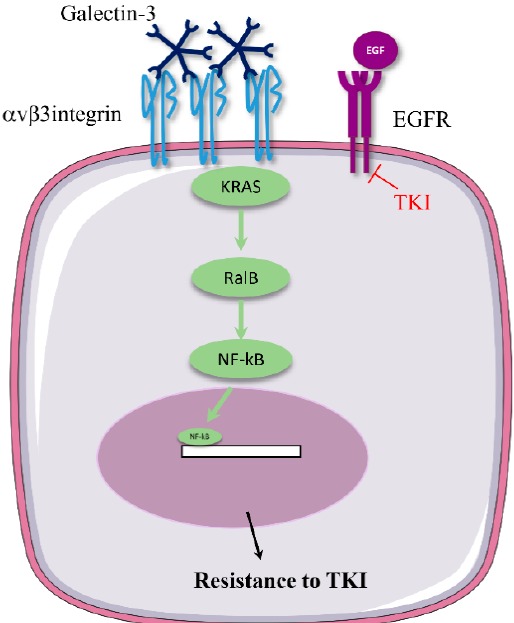
Figure 3. β 3 / KRAS / RalB / NFkB pathway mediates EGFR-targeted therapy resistance. In EGFR TKI-treated tumors, cells overexpressing α v β 3 integrin are selected, leading to a resistant tumor. By binding to oligosaccharide moieties of β 3 integrin, galectin-3 promotes integrin / KRAS interaction independently of integrin-mediated adhesion to ECM proteins. KRAS activates the downstream RalB / NFkB pathway that leads to therapy resistance by promoting a stem cell-like phenotype (adapted from [19]).